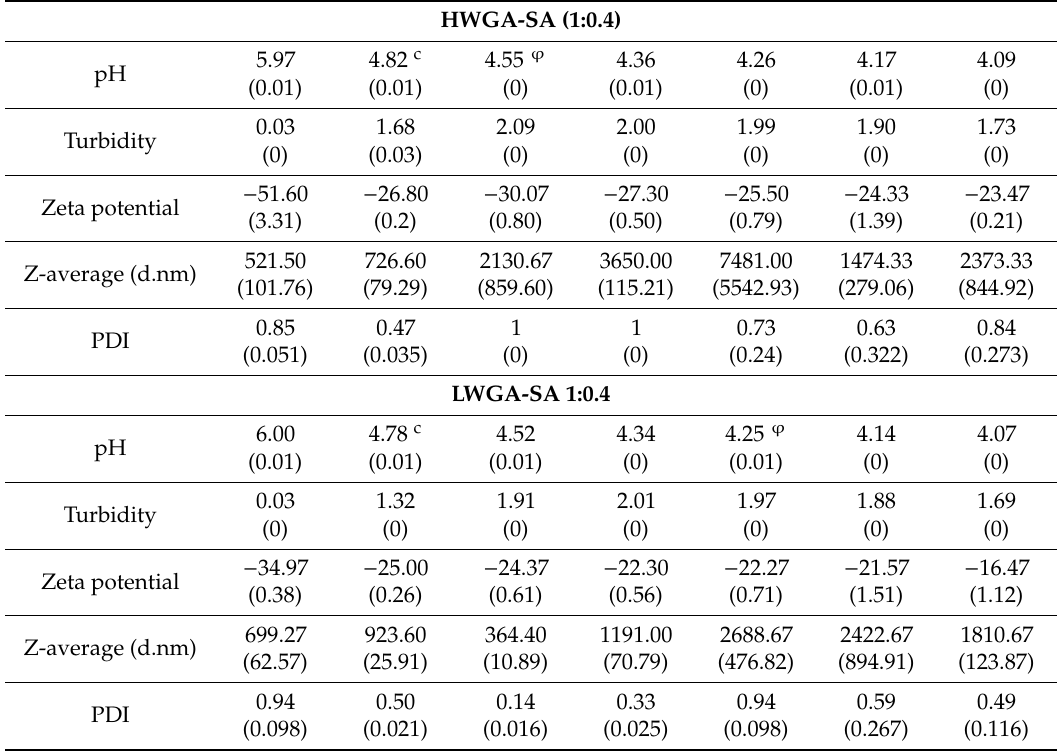
Table 1. pH dependence of the reaction between HWGA-SA and LWGA-SA at (1:0.4) polymer